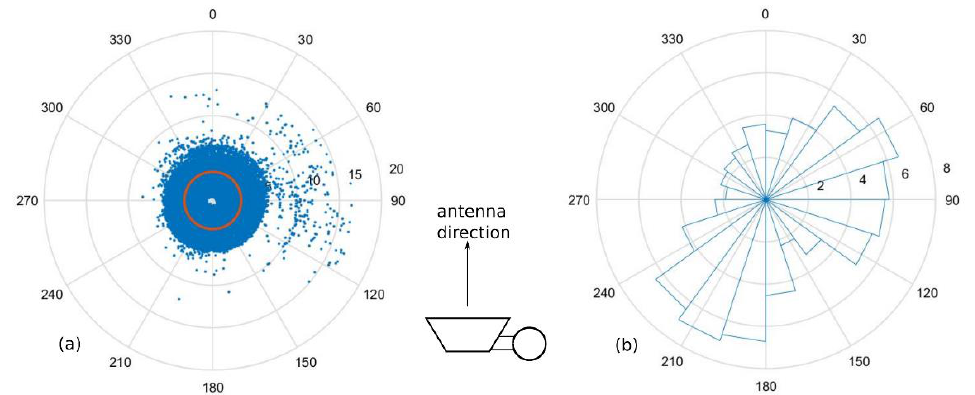
Figure 12. ( a ) Attenuation values plot versus wind direction, with threshold shown; ( b ) histogram of attenuation values that exceed threshold according to the wind direction (the number of samples ×1000). The antenna is facing 0°.